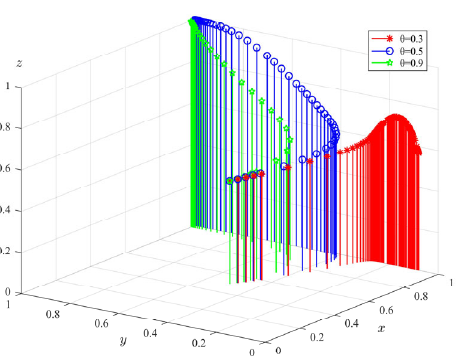
Figure 7. The impact of subsidy coefficient ( θ ) on the evolution of tripartite behavior. (3) The impact of penalty coefficient ( η ) on tripartite evolutionary behavior Keeping other parameters of the model unchanged, we changed the penalty coeffi ‐ cient of government departments and took η = 0.2, 0.5, 0.8; the evolution path of each subject is shown in Figure 8. The graph shows that an increase in the penalty coefficient causes a slight acceleration in the rate at which government departments choose to evolve their regulatory behavior to a steady state, but the overall change is not signifi ‐ cant. The evolutionary rate of private pension institutions’ choosing to regulate their operations and the elderly’s choosing to participate is significantly accelerated with the increase in η . The above results show that the increase in the punishment of government departments can effectively accelerate the evolution of private pension institutions to a standardized operating state and can also improve the participation of the elderly in us ‐ ing elderly care services. It is easy to understand that when the government imposes heavy penalties on the elderly care institutions for violating the regulations, the fine is a great loss to the institutions. Any enterprise is afraid of loss, because it will damage the overall interests of the enterprise. In order to ensure that the private pension institutions can continue to operate in the future, they will gradually regulate their own operation behavior and dare not know the law. The greater the punishment, the higher the loss to the elderly care institutions, and the better the effect of promoting their standardized operation. For the government department, the fine is a sum of income, which gives the government department more power to supervise. The willingness of the elderly to par ‐ ticipate is directly proportional to the probability of standardized operation of private pension institutions. In other words, the increase in penalty is also conducive to im ‐ proving the trust of the elderly in private pension institutions.